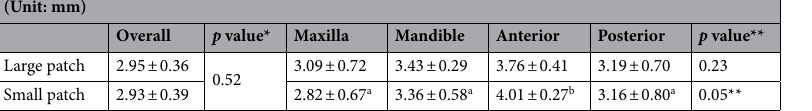
Table 2. Mean value of surface deviation in overall three-dimensional models and the respective anatomical region. *Mann–Whitney test, 95% confidential interval. **Kruskal–Wallis test and Dunn’s multiple comparisons post-hoc test, 95% confidential interval.